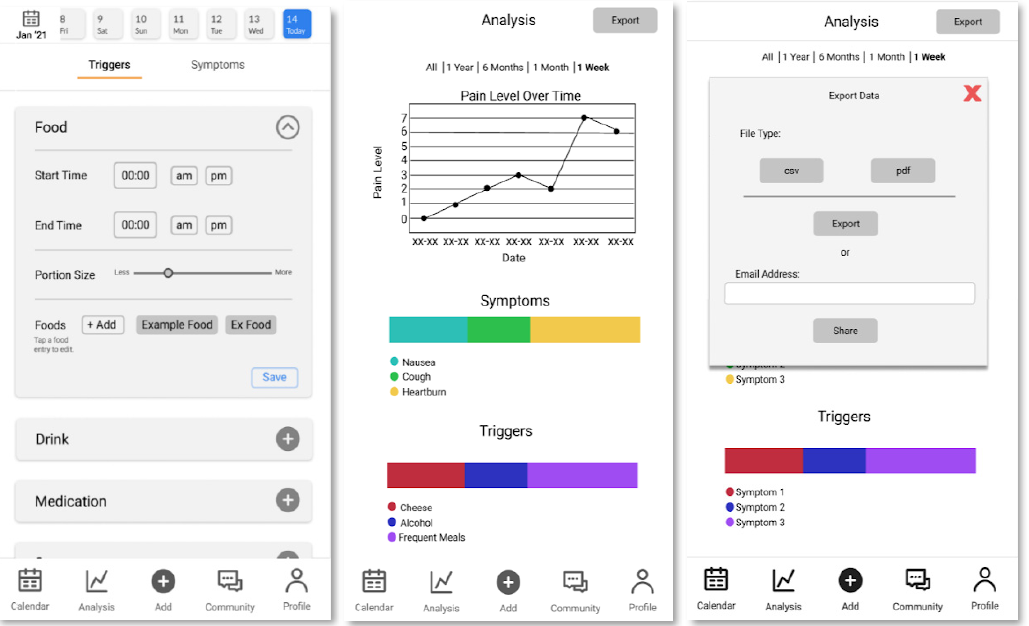
Figure 3. Pages from medium fidelity prototype. From left to right: calendar page, analysis page, export feature, trigger/symptom input page, food trigger ingredient input page, and user profile page.